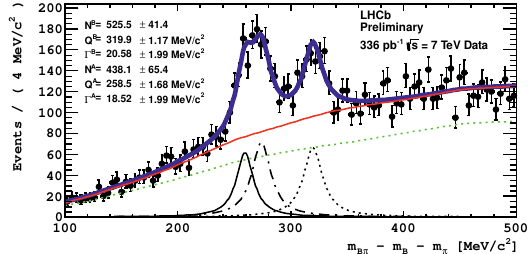
Figure 6. Q ( B + π − ) distribution. LHCb data (black markers) and the total fit are superimposed. Individual components contributing to the total fit are combinatorial background and associated production (red, green for → B ∗ + π − (solid black), B ∗ 0 → B ∗ + π − (dot-dashed black) and B ∗ 0 → B + π − combinatorial background only), B 0 1 2 2